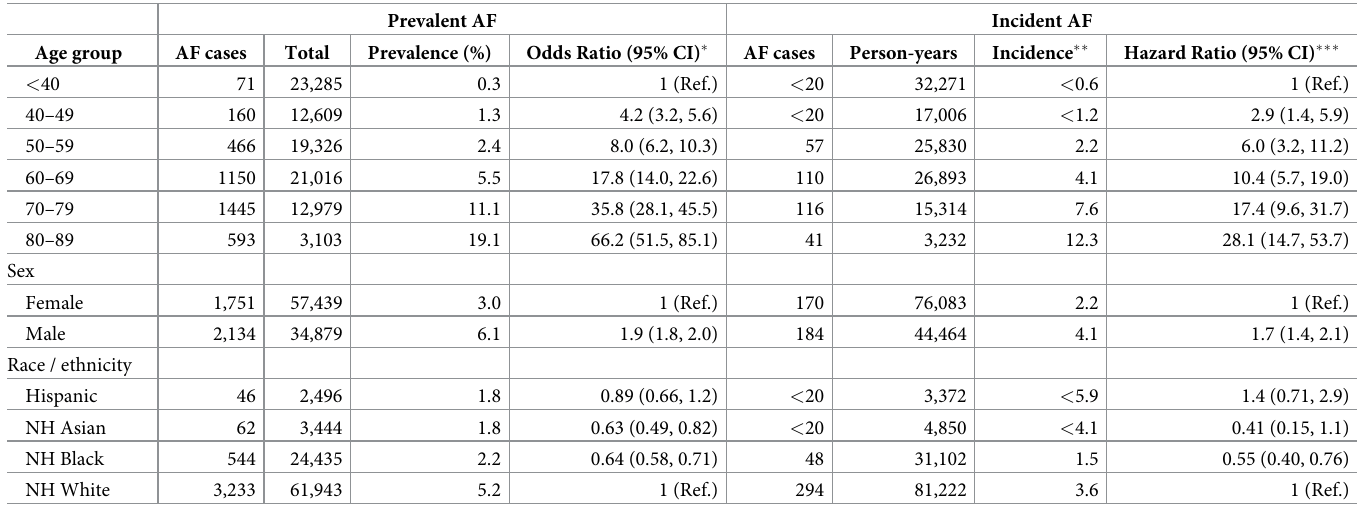
Table 3. Prevalence and incidence of EHR-derived AF by age, sex, and race/ethnicity, All of Us Research Program, 2017–2019. Prevalent